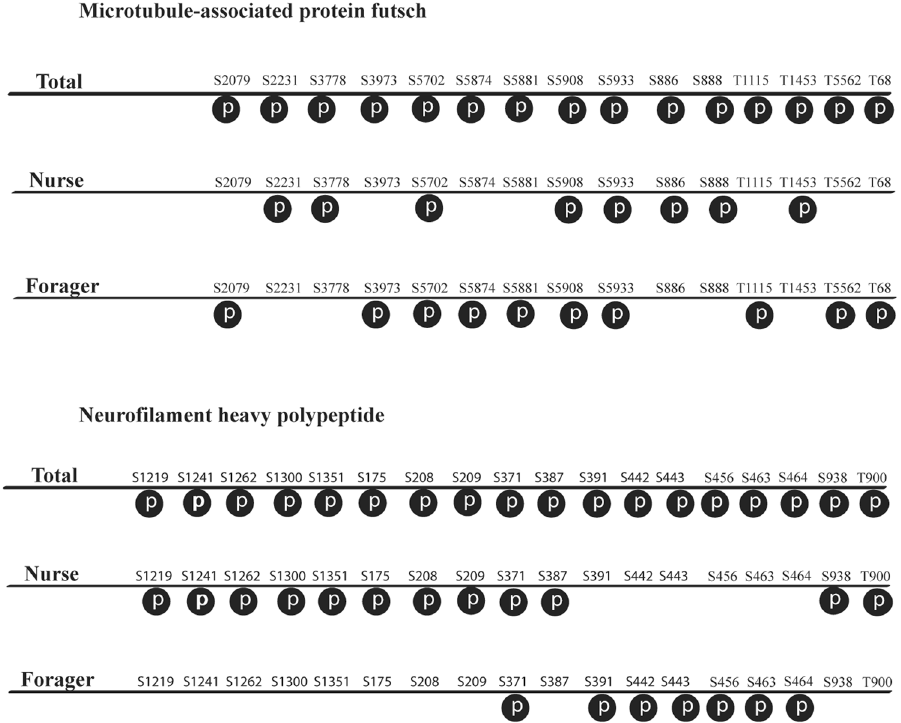
Figure 2. Phosphorylation patterns of two selected phosphoproteins identified in our dataset in the nurse and forager bees. ( A ) Microtubule-associated protein futsch. ( B ) Neurofilament heavy polypeptide. “S” stands for serine and “T” stands for threonine, the number indicates the position of the amino acid in the polypeptide chain, and phosphosite in depicted as a “P” in the black